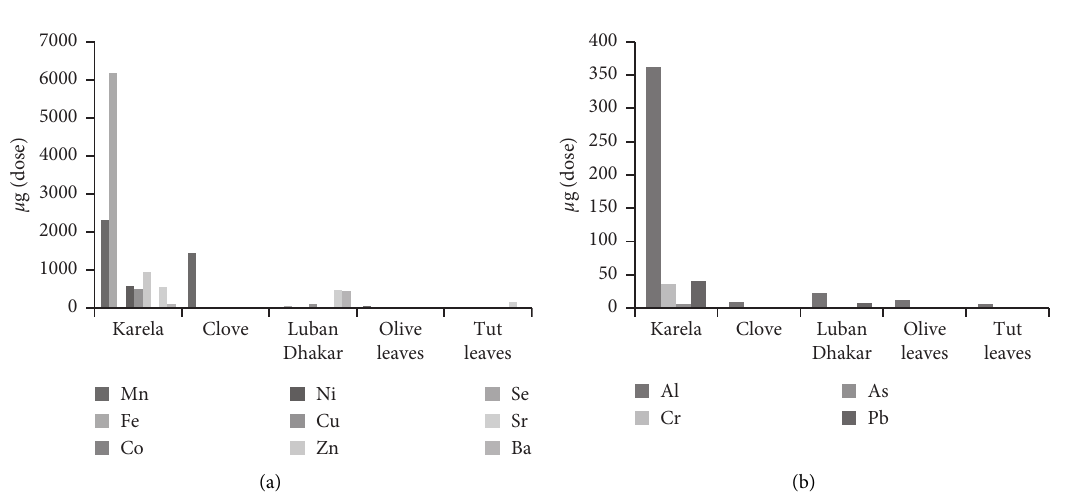
Figure 1: Amount ( µ g) of each element in each dose of a plant: (a) essential elements and (b) toxic